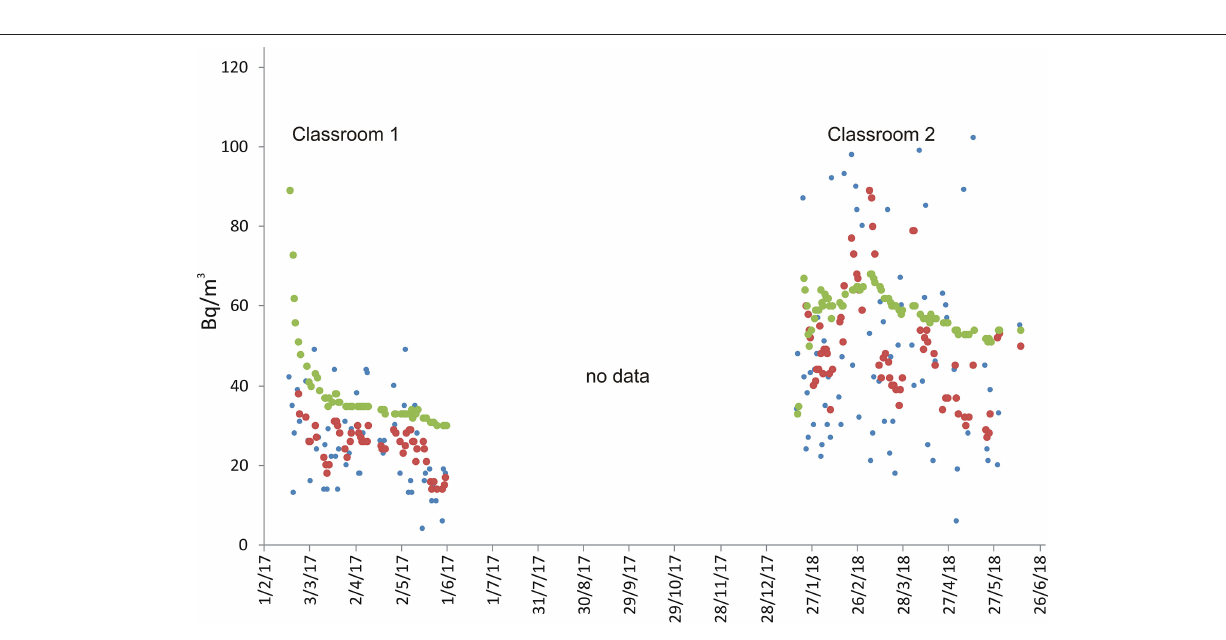
FIGURE 8 | Radon measurements recorded in the Giarre municipality, at location 7 (see Figure 1 , sensors 11 and 12) in two different classrooms inside a high school. Radon concentration are presented as daily (blue), weekly (red), and long-term (green) averages. “No data” indicates periods of no